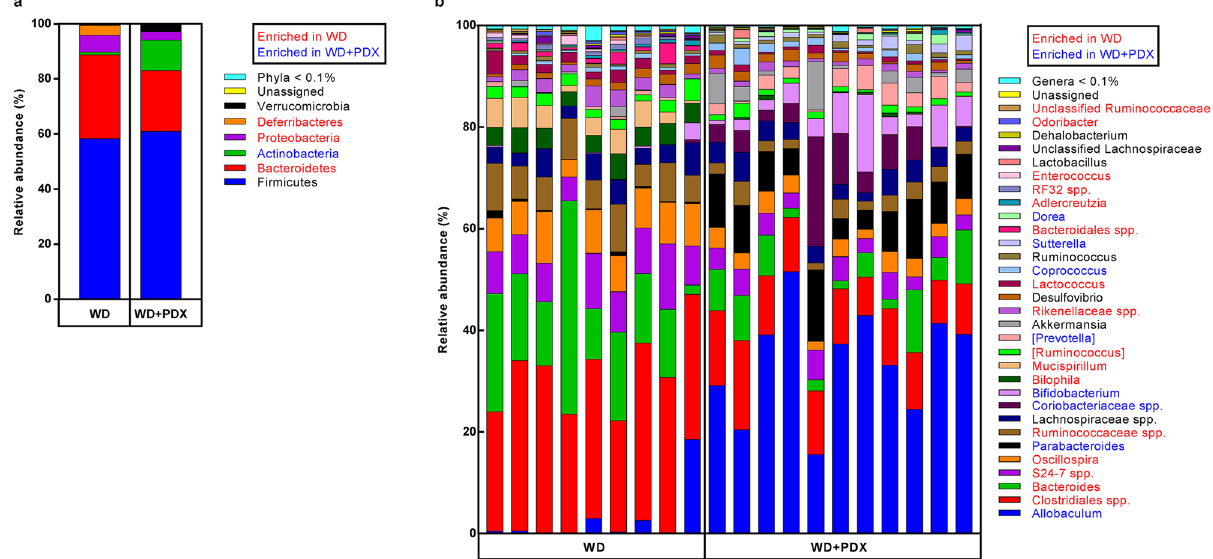
Figure 5. Relative abundance of caecal bacteria at ( a ) phylum and ( b ) genus level of taxonomy in WD and WD + PDX mice. Square brackets indicate the Greengenes database notation for proposed taxonomy. Blue colored taxa were significantly enriched in WD mice and red colored taxa are significantly enriched in WD + PDX mice. p < 0.05; Mann-Whitney U test with false discovery rate